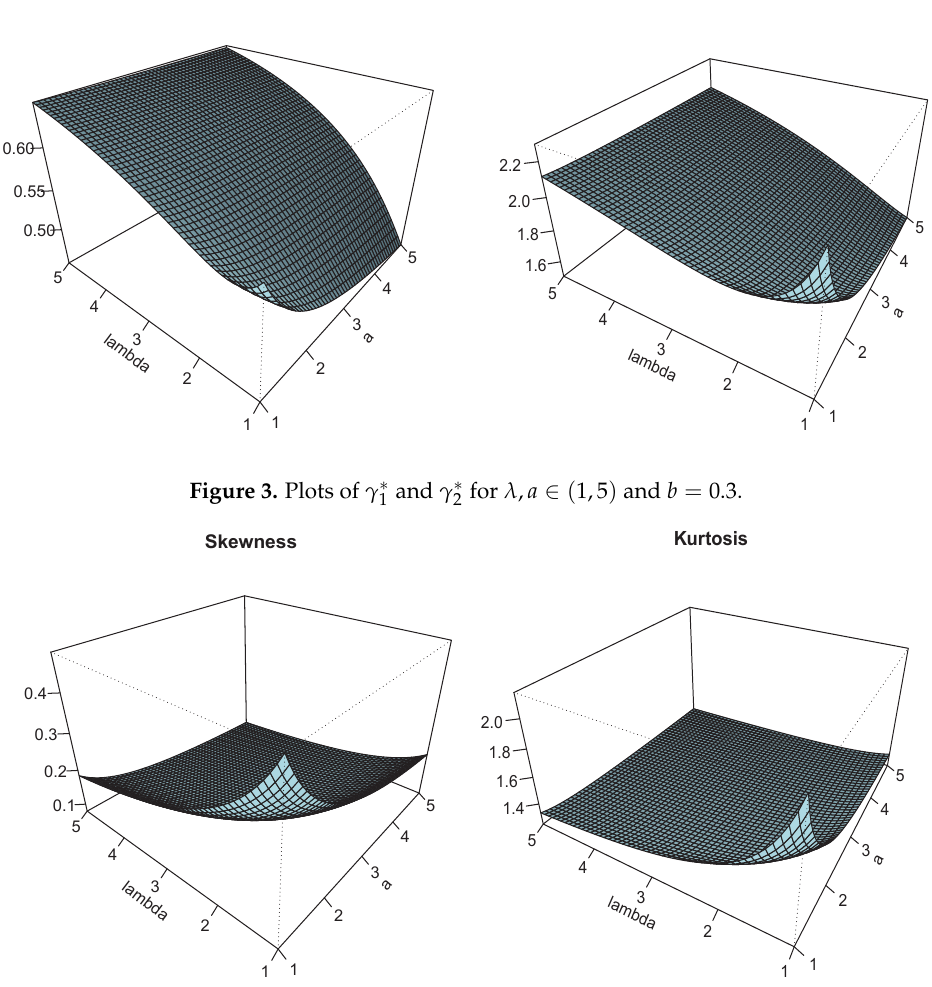
Figure 4. Plots of γ ∗